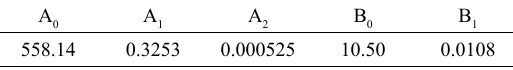
Table 3. Constants for the heat capacity (Cp) and thermal conductivity (k) of super duplex stainless steel (SDSS) determined using the proposed method (Equations 2 and 3).